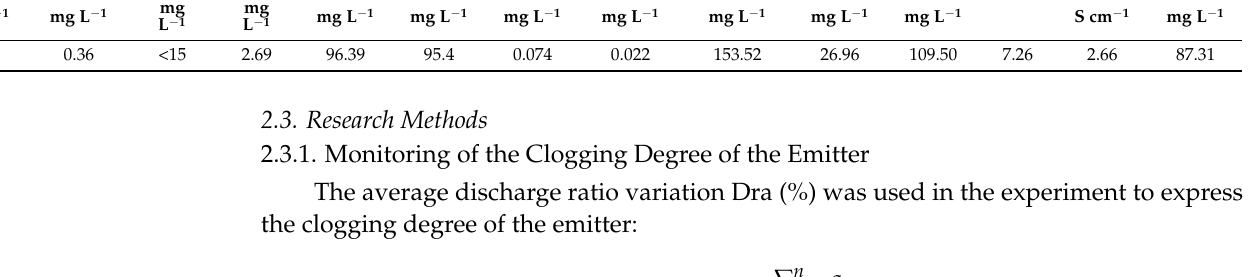
Table 2. Test of water quality.